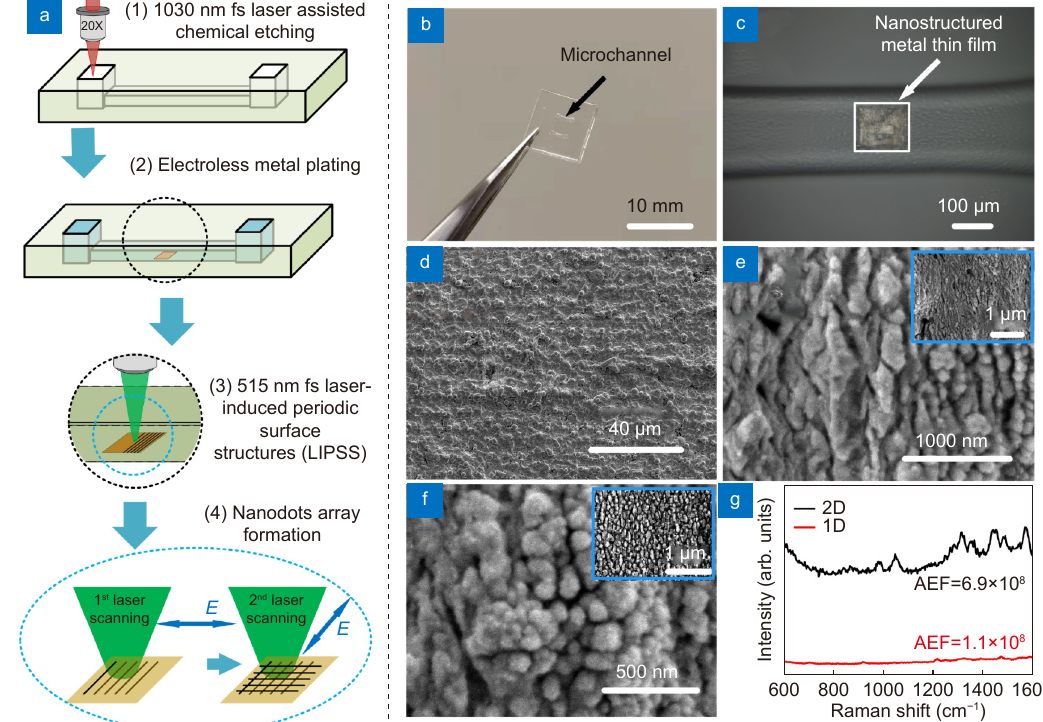
Fig. 2 | ( a ) Schematic of the fabrication procedure for the microfluidic SERS chip using hybrid fs laser processing. (1. Glass microfluidic chip fab- ricated by fs laser assisted chemical etching. 2. Femtosecond laser selective ablation at the bottom surface of the microchannel. 3. Selective metallization on the laser ablated region by electroless metal plating. 4. Nanostructuring on the metal film by fs LIPSS.) ( b ) Photograph of micro- fluidic SERS chip fabricated by hybrid fs laser processing. ( c ) Optical microscope image showing the SERS substrate formed at the bottom sur- face of the microchannel embedded in the glass substrate. SEM images of ( d ) original metal film, ( e ) ripples generated by 1 st laser scanning and ( f ) nanodots generated by 2 nd laser scanning (Insert: low magnification of SEM image). ( g ) Raman spectra of 10 -9 M Rhodamine 6G (R6G) on 2-D (black) and 1-D (red) nanostructured SERS